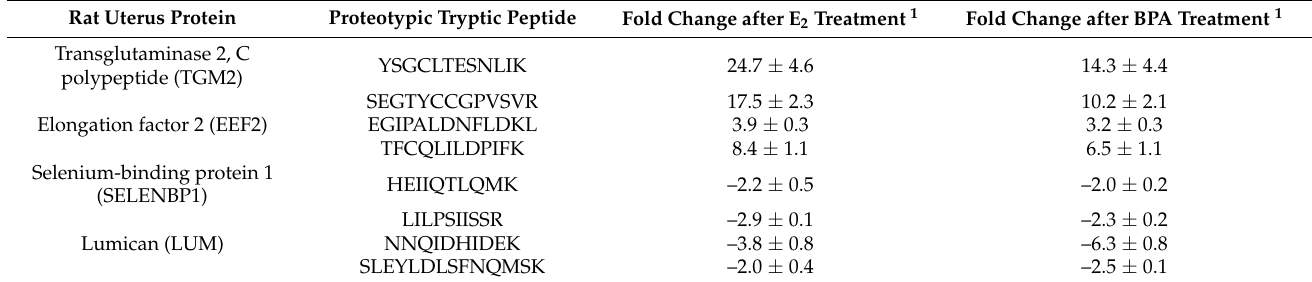
Table 1. E 2 -regulated proteins in OVX rat uterus verified by targeted proteomics and applied to testing BPA [34,53–58] as a well-known estrogenic EDC.